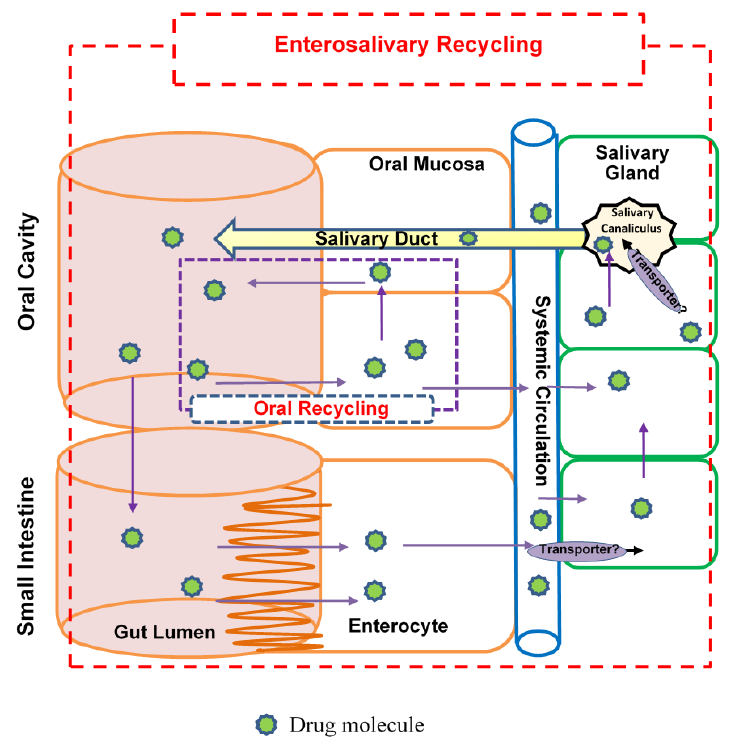
Figure 5. The proposed entero-salivary drug recycling scheme.